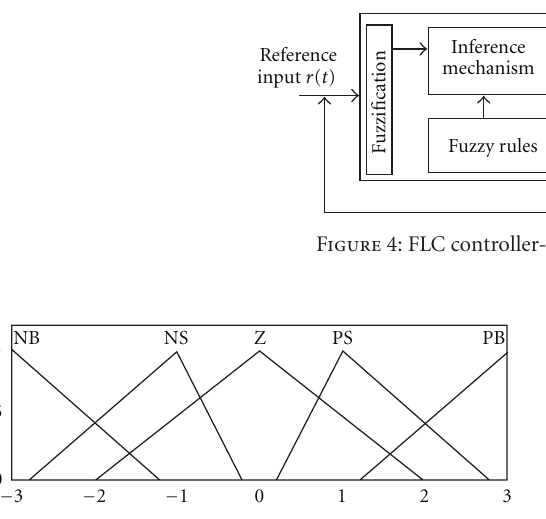
Figure 7: Fuzzy controller output variable “ u ”.